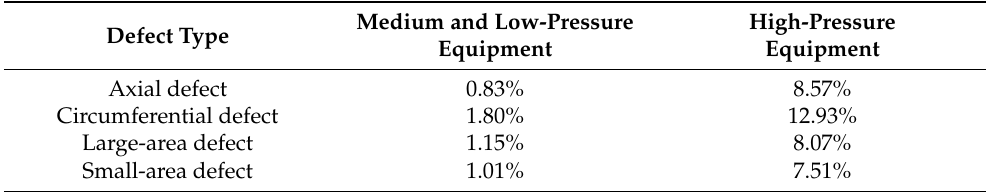
Table 11. The relative reduction in the average radius of the limit load curves of straight pipes with local wall-thinning defects under the influence of axial